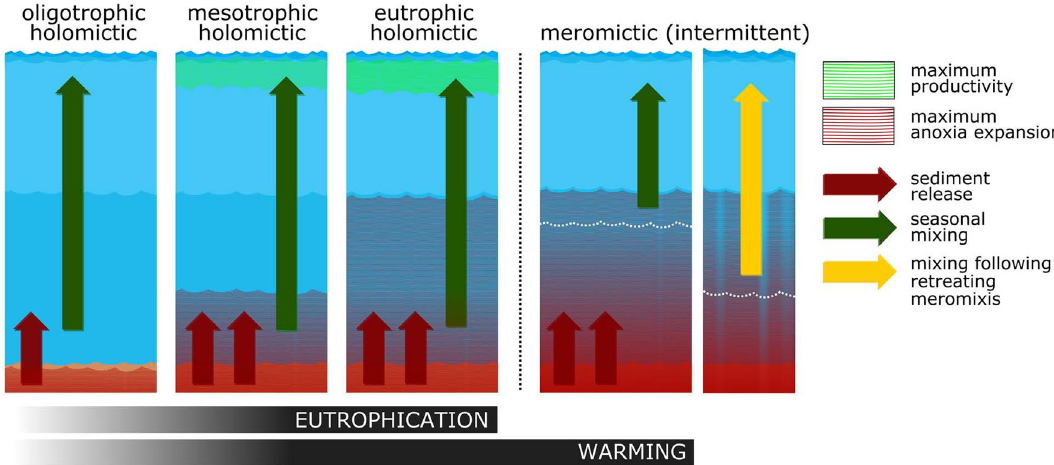
Figure 7. Conceptual illustration of the combined effects of eutrophication and climate forcing on lake trophy. In the holomictic case, stratification first separates epi- and hypolimnion (shades of blue) and transports P from deep waters to the surface upon yearly mixing (green arrow). More P may be transported when larger shares of deep sediments are in anoxic waters. A shift towards warming-induced meromixis could first induce a non- linear response: surface re-oligotrophication together with persistent deep-water anoxia. However, nutrient accumulation in the deep waters bears the potential to trigger episodes of high productivity when meromixis suddenly retreats, allowing surface waters to mix deeper (yellow arrow), as for example during an exceptionally cold